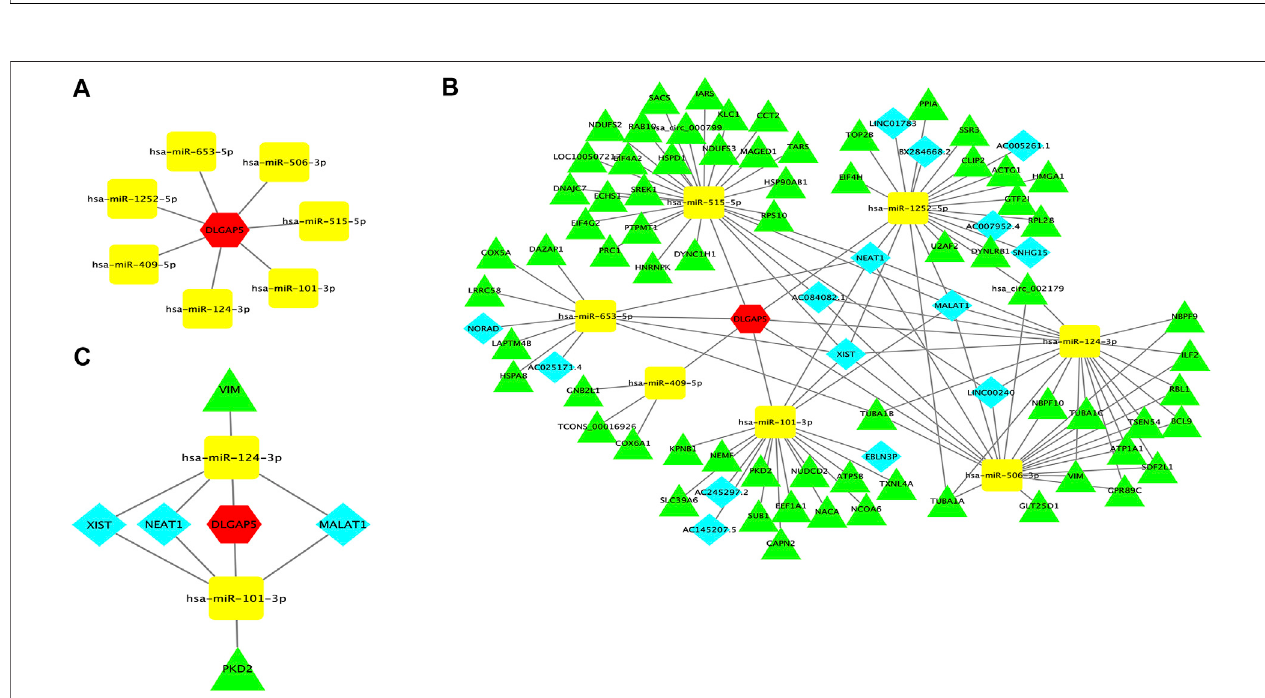
FIGURE 6 | DLGAP5-miRNAs correlation network and ceRNA network. (A) A correlation network between DLGAP5 with seven target miRNAs. Seven target miRNAs of DLGAP5, including hsa-mir-101-3p, hsa-mir-124-3p, hsa-mir-409-5p, hsa-mir-515-5p, hsa-mir-506-3p, hsa-mir-653-5p, and hsa-mir-l252-5p, were predicted and selected by StarBase database. (B) DLGAP5 and all selected target miRNAs, lneRNAs and circRNAs were constructed a ceRNA network by using Cytoscape software. (C) The ceRNA network of the potential RNA regulatory pathways. The red hexagon represents DLGAP5, blue diamond represents lncRNA, yellow round rectangle represents miRNA, and green triangle represents circRNA.